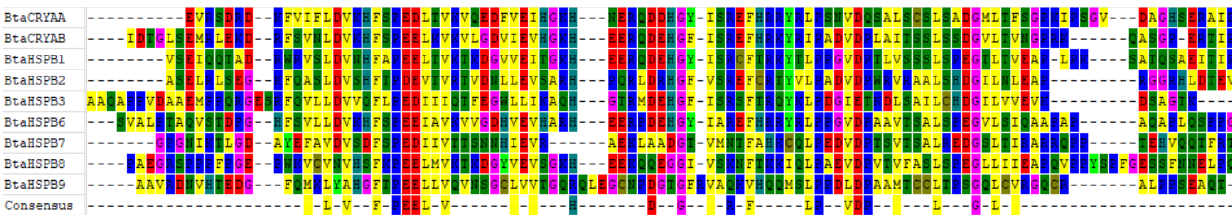
Figure 1. Multiple sequence alignment of cattle heat shock protein 20 (HSP20) domains, excluding ODF1, a more diverse member of HSP20 gene family. The amino acid residues evolutionarily conserved are shown in as the consensus at the bottom. The sites with amino acids that have the same biochemical characteristics are shown as colored boxes. Bta, Bos taurus